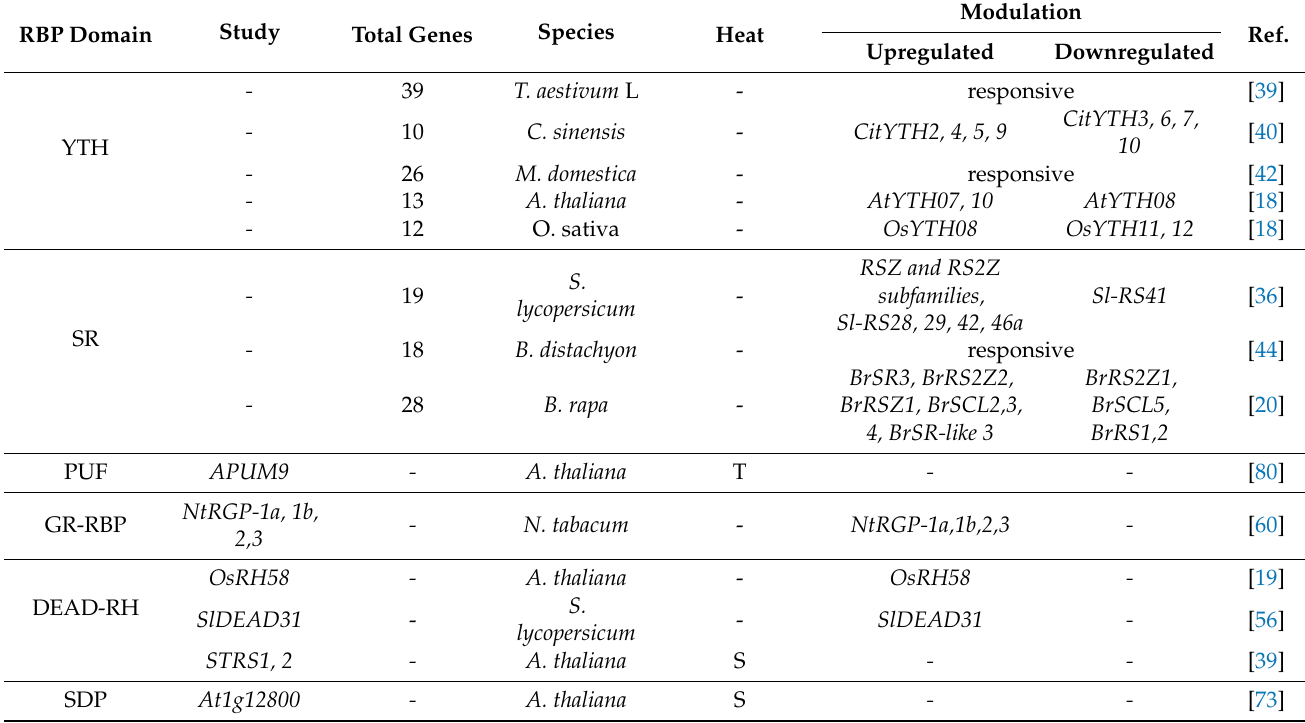
Table 3. Plant RNA binding proteins implicated in heat/high-temperature stress